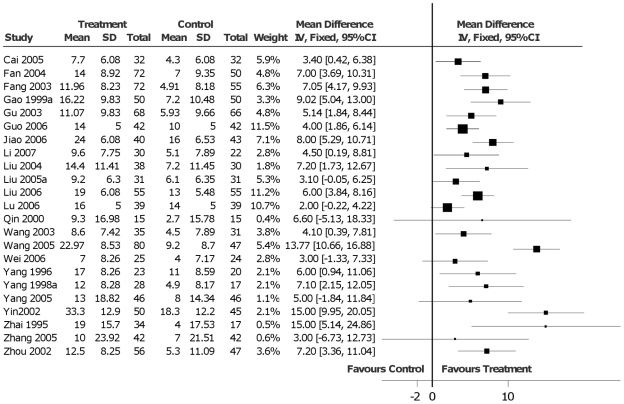
Data analysis of left ventricular ejection fraction.